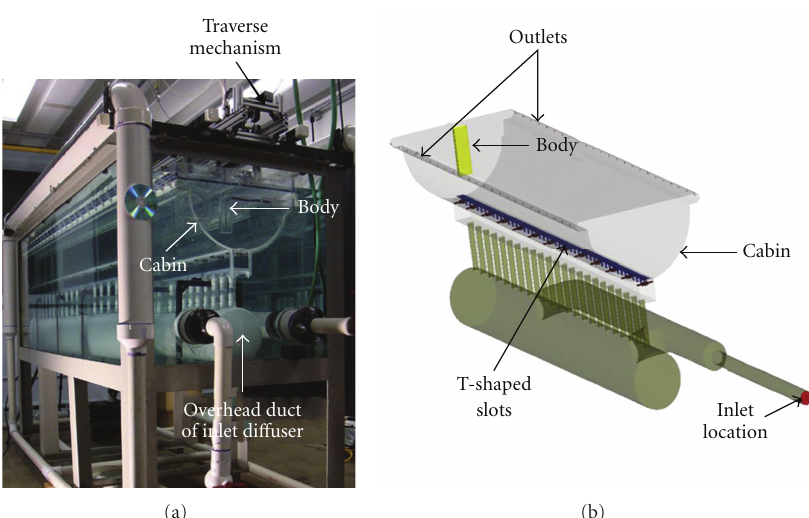
Figure 13: (a) Small-scale experiments test facility that simulates a aircraft cabin. (b) 3D digital geometry of the facility to be used in the CFD models